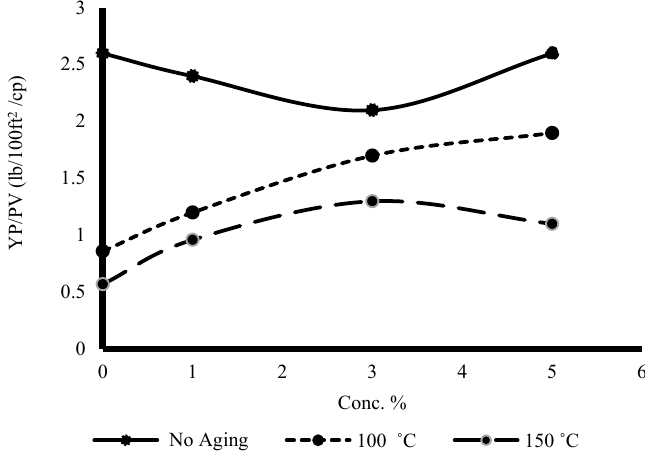
Figure 1. YP/PV of AA:Gly NADES-based mud samples before and after aging.